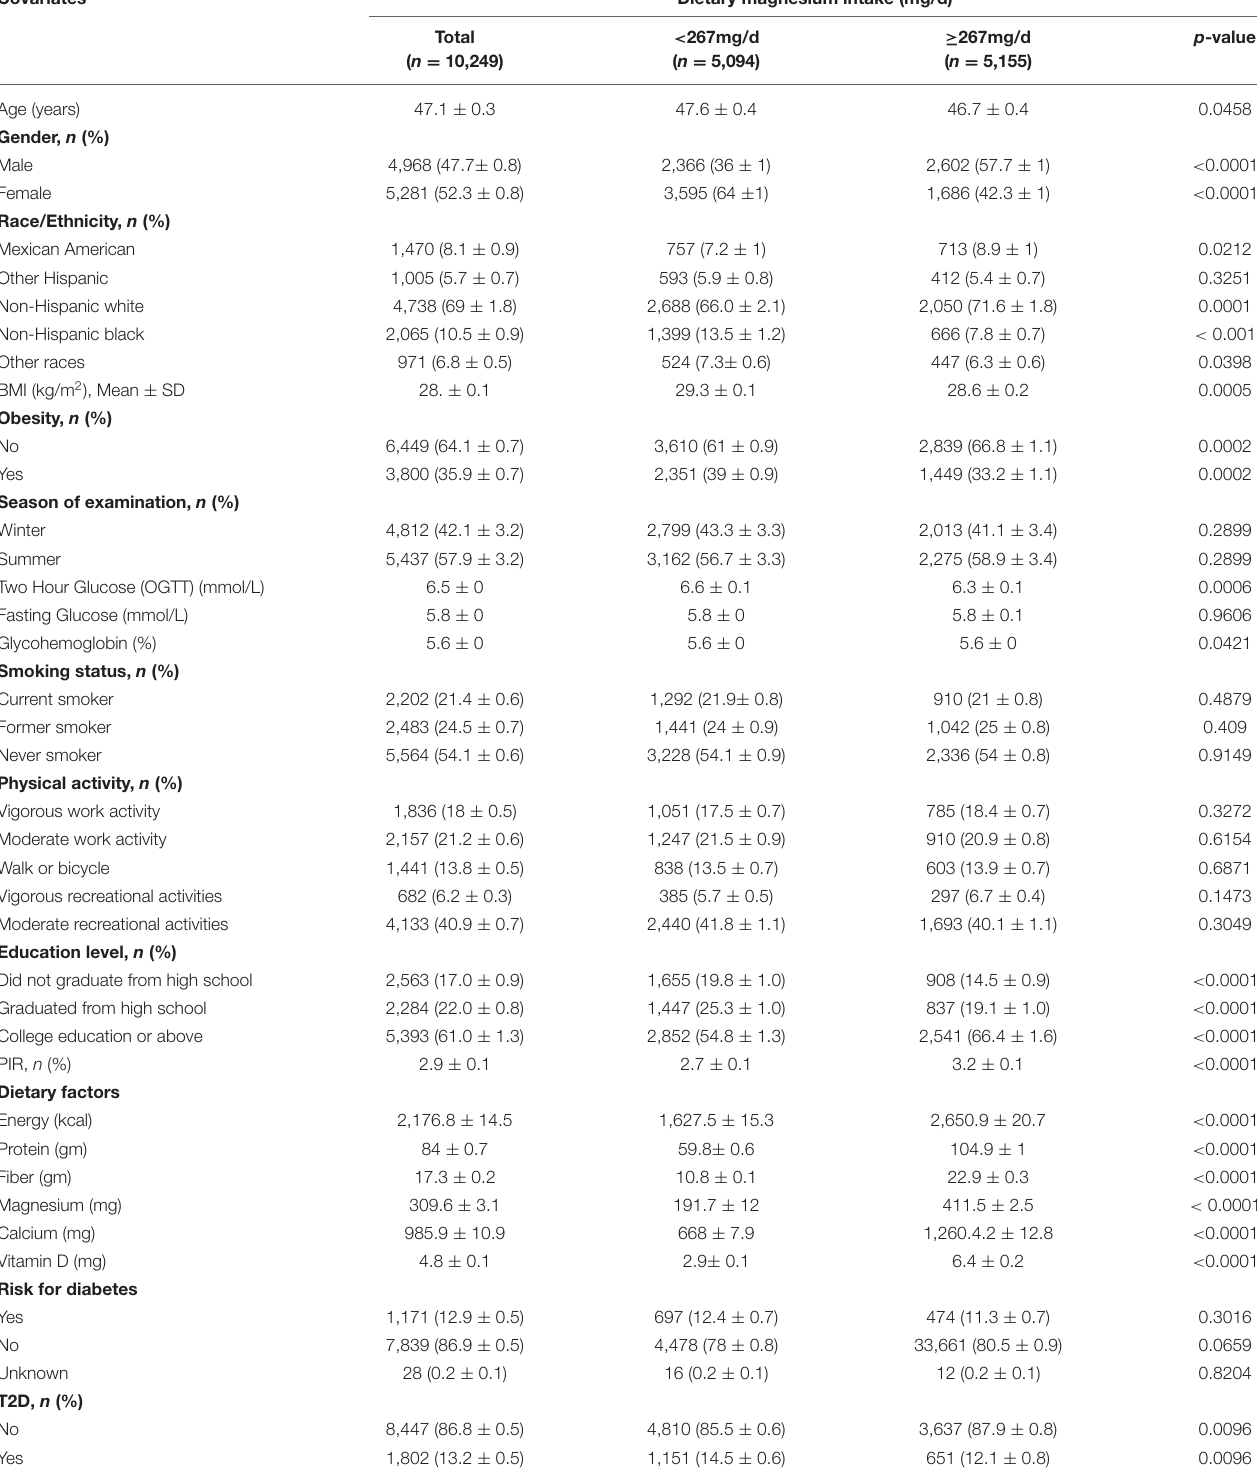
TABLE 1 | Baseline characteristics of participants.